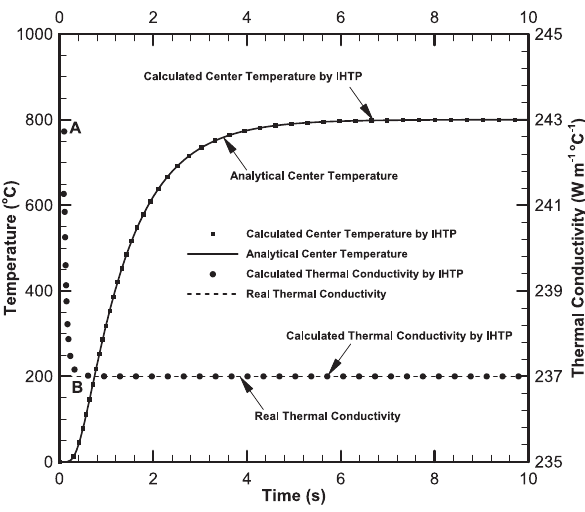
Fig. 11: Validation of IHTP code in a virtual